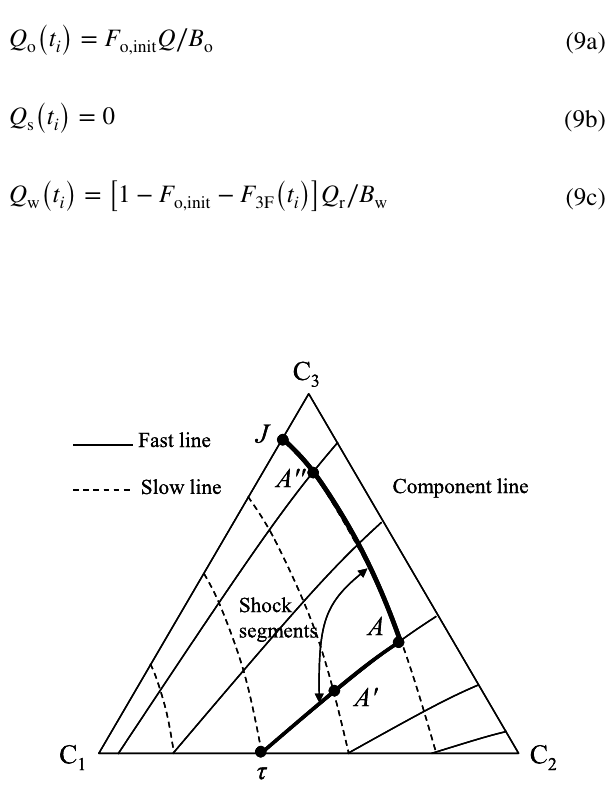
Fig. 1 Diagram of fast line and slow line (Rogers and Grigg